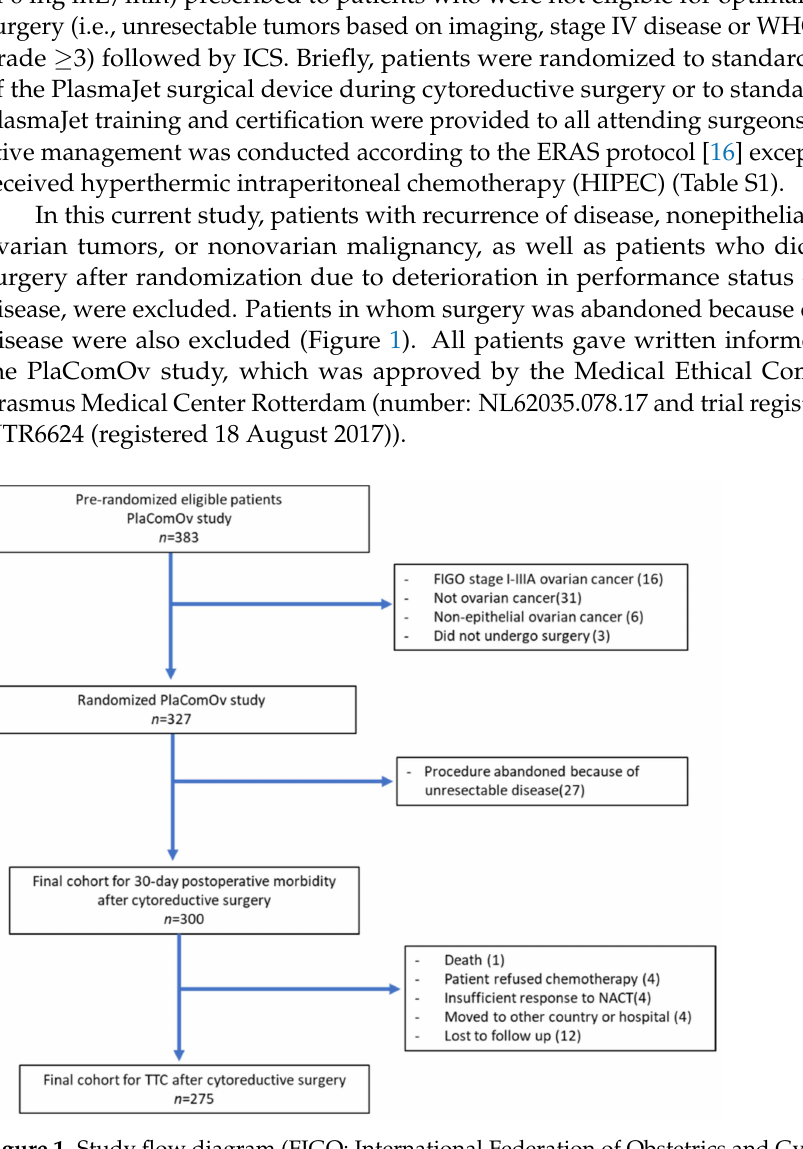
Figure 1. Study flow diagram (FIGO: International Federation of Obstetrics and